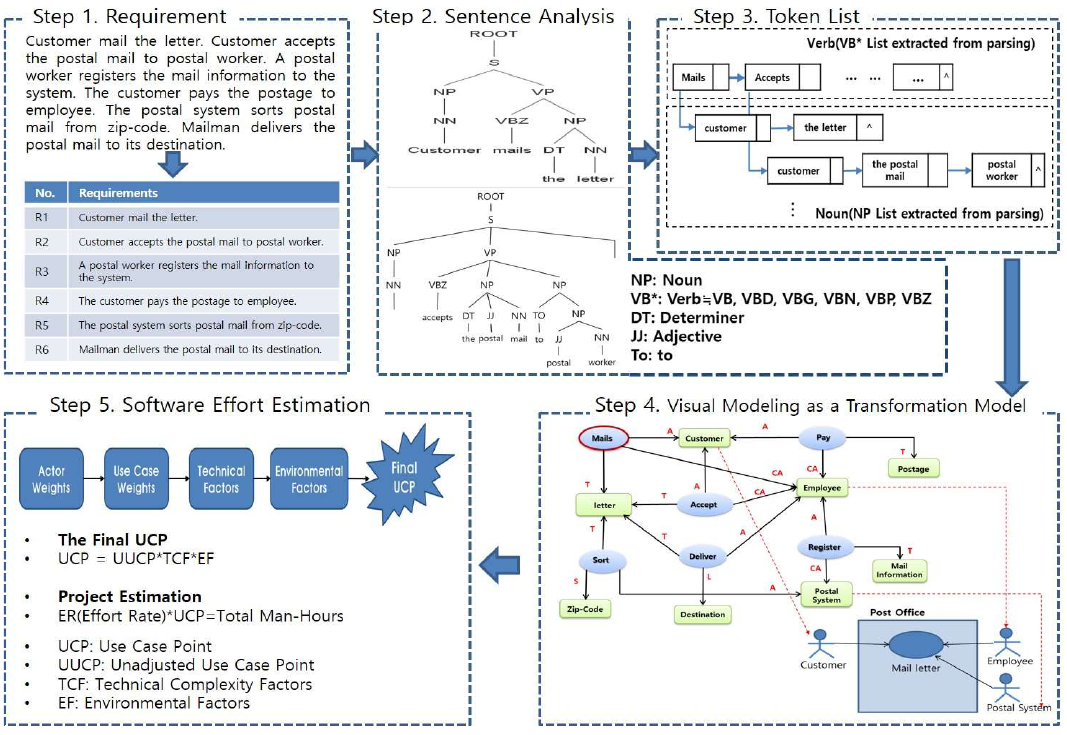
Figure 5. Use case extraction process.